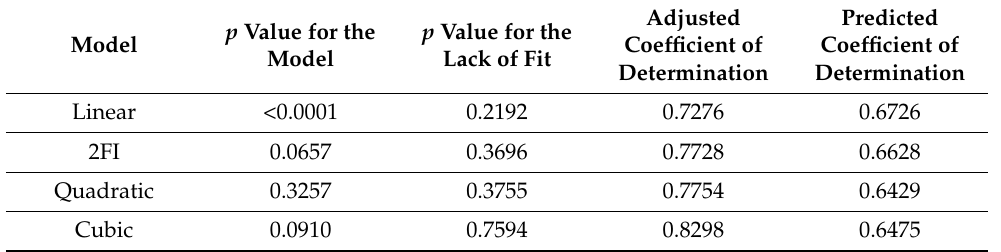
Table 6. Simulation of four models in Design Expert for notch corrosion after 240 h in the salt-spray test